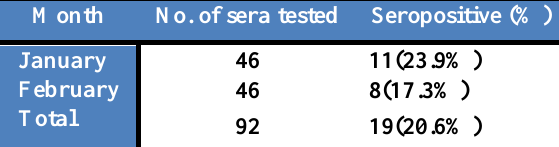
Table, 5: Distribution of T.gondii in camels by using ELISA according to according to the